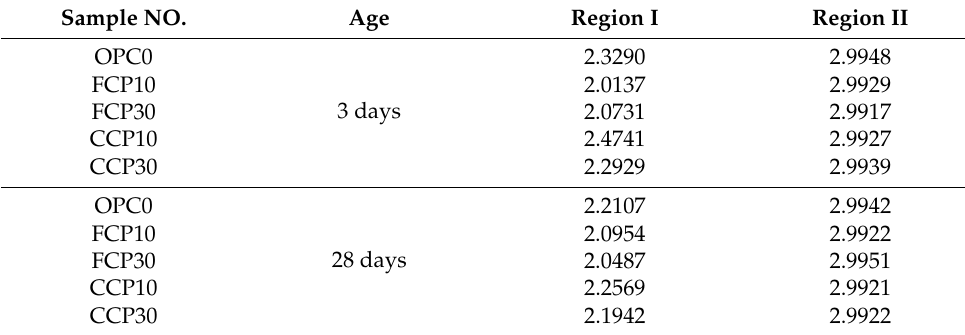
Table 4. Multifractal analysis of coral powder–cement slurry by Ji’s model. Sample